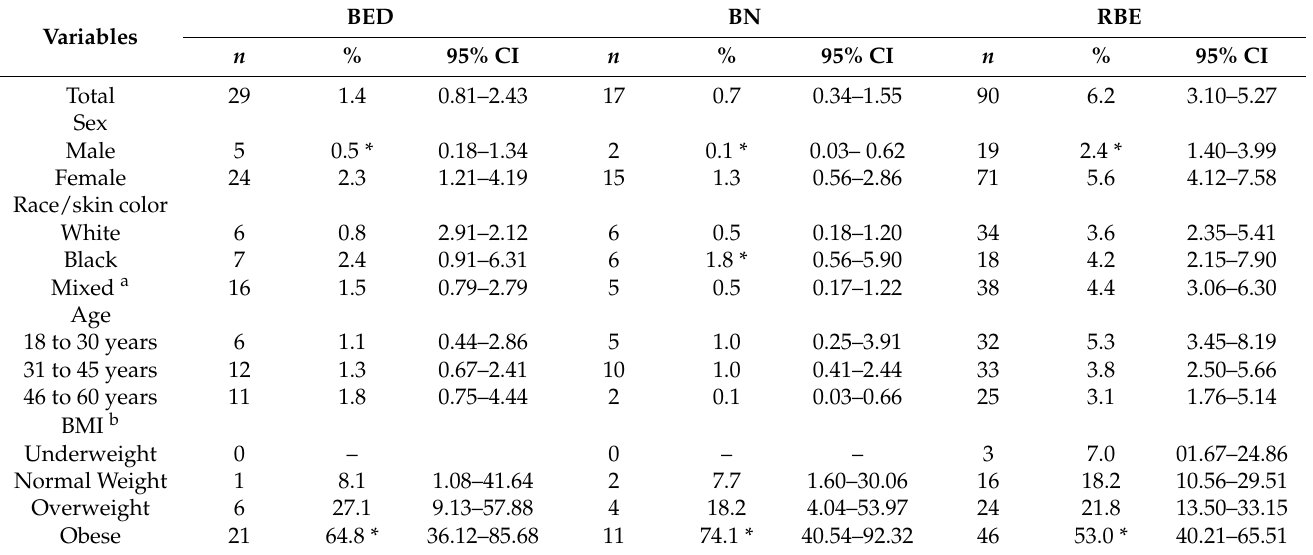
Table 2. Prevalence of binge eating spectrum conditions according to sociodemographic characteris- tics and weight